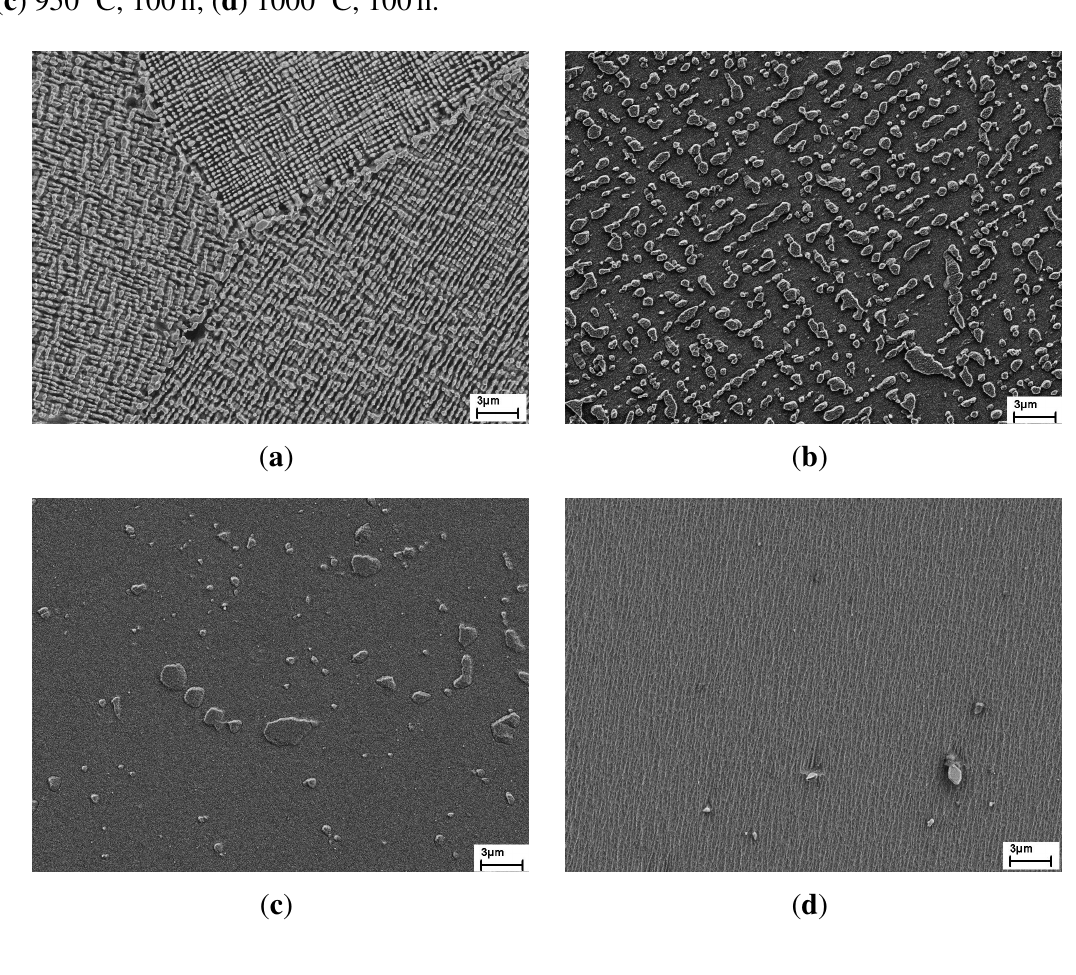
Figure 12. SEM-images (secondary electrons) of the alloy Ni-30%Cu-6%Al-5%Cr after different heat treatments. Etched with Adler-reagent. ( a ) 800 ◦ C, 100 h; ( b ) 900 ◦ C, 100 h; ( c ) 950 ◦ C, 100 h; ( d ) 1000 ◦ C, 100